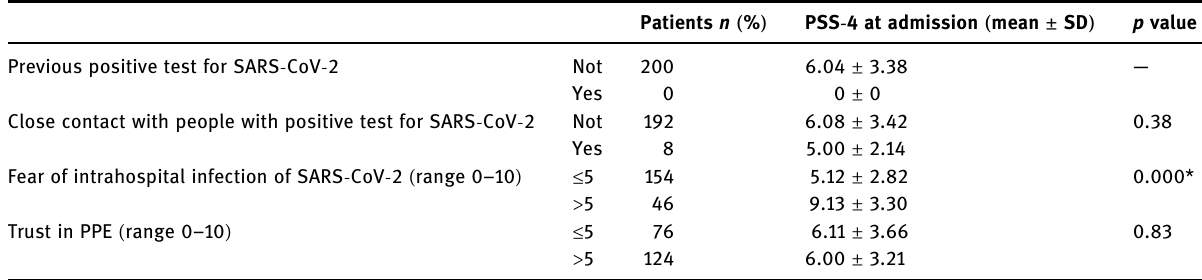
Table 3: Survey on COVID - 19 and univariate analysis of mean values of PSS - 4 at hospital